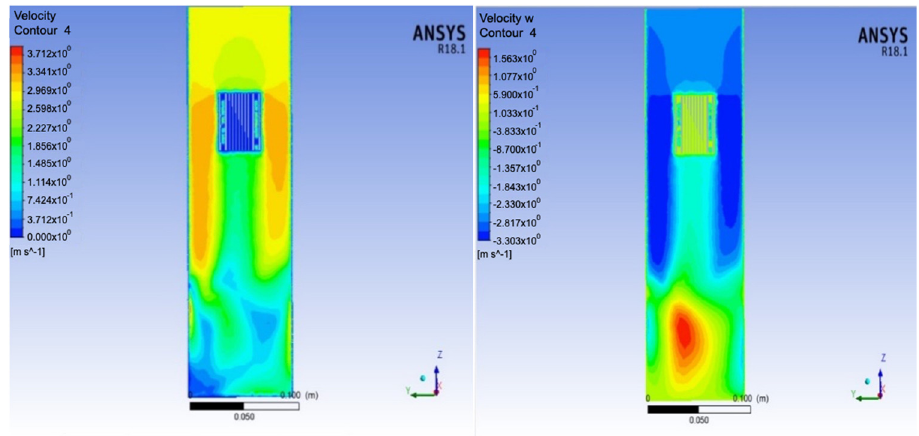
Figure 11. Velocity distribution along the model.